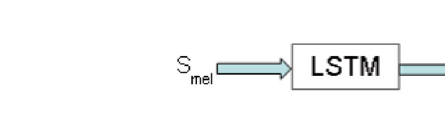
FIGURE 6 | Structure of neural network.